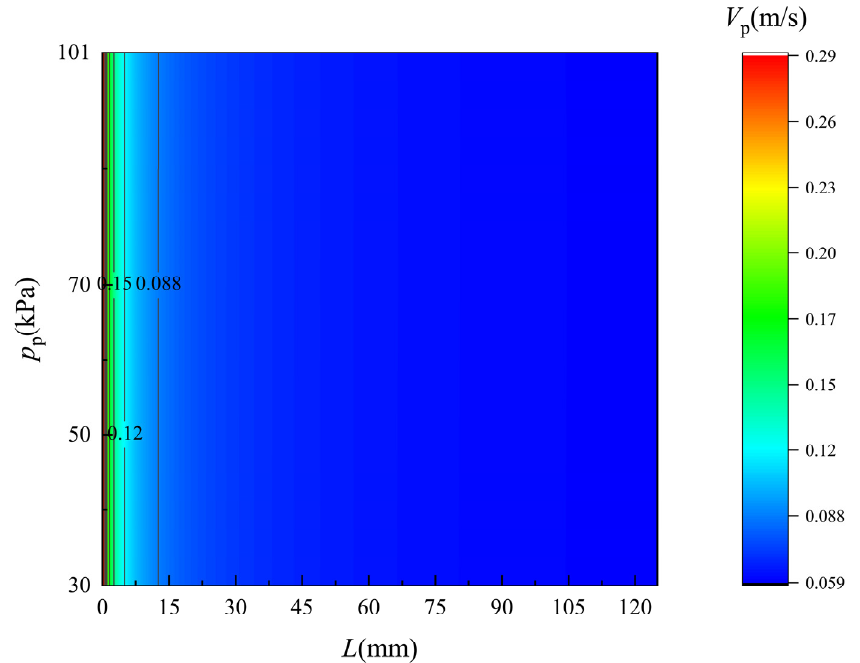
Figure 9. Velocity distribution of flow along the permeate side of the membrane surface. T f = 318 K.